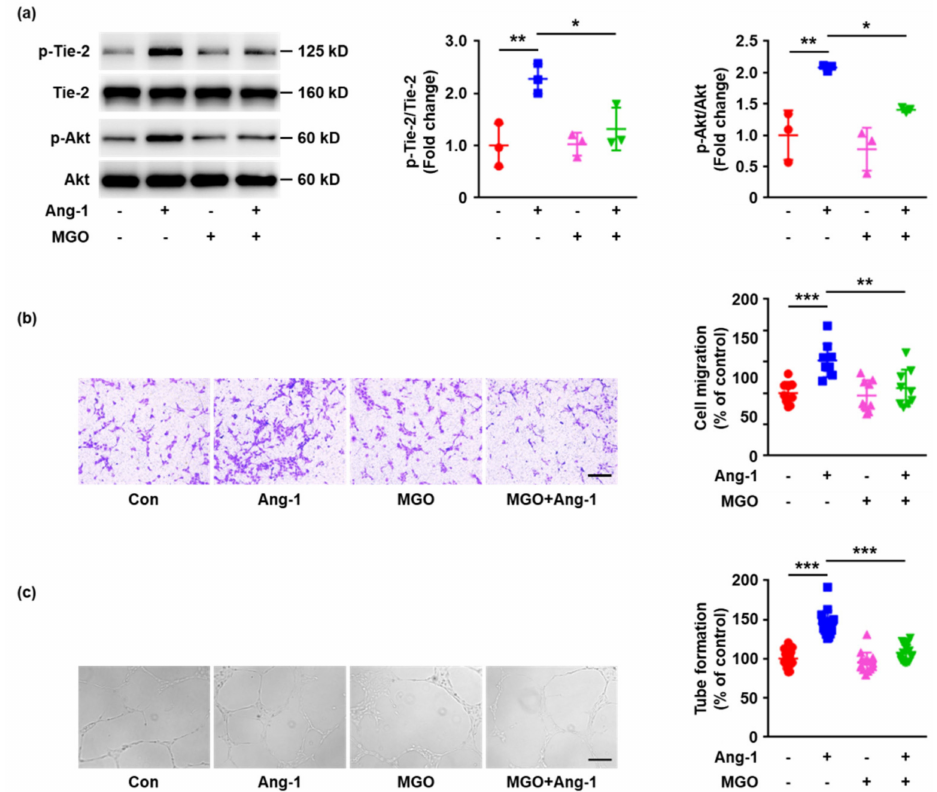
Figure 3. MGO inhibits Ang-1 signaling activation and Ang-1–induced angiogenesis. ( a ) HUVECs were exposed to MGO (100 µ M) or vehicle control for 24 h, followed by stimulation with Ang- 1 (200 ng/mL) for 15 min. Phosphorylation (p) of Tie-2 and Akt and total Tie-2 and Akt were detected by Western blotting. Representative images of three independent experiments are shown and densitometric analysis of phosphorylated Tie-2 and Akt normalized to total Tie-2 and Akt was performed. ( b ) HUVECs cultured in six-well plates were exposed to MGO (100 µ M) or vehicle control for 24 h. The cells were then detached and added to the upper chambers containing porous filters, followed by stimulation with Ang-1 (200 ng/mL) or vehicle control. After 24 h, the cells were fixed, stained, and the cells that had migrated to the lower chambers were counted. Representative images of three independent experiments are shown and quantitative assessment was performed. ( c ) HUVECs cultured in six-well plates were exposed to MGO (100 µ M) or vehicle control for 24 h.